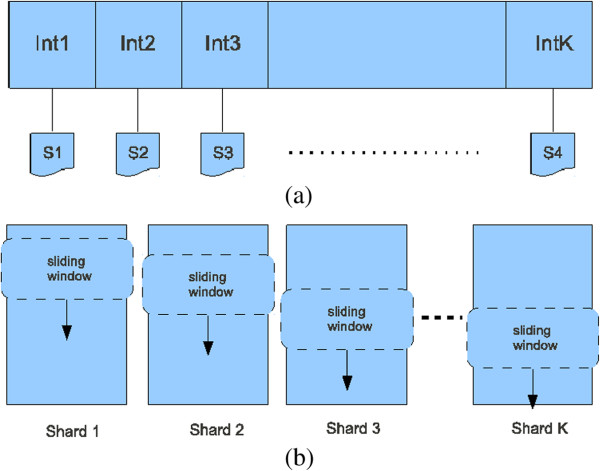
Efficient disk access with GraphChi. (a) Shards: Int1,…IntK refer to the K intervals in which the vertices are split, while S1,…SK to the corresponding shards (b) Parallel Sliding Windows.